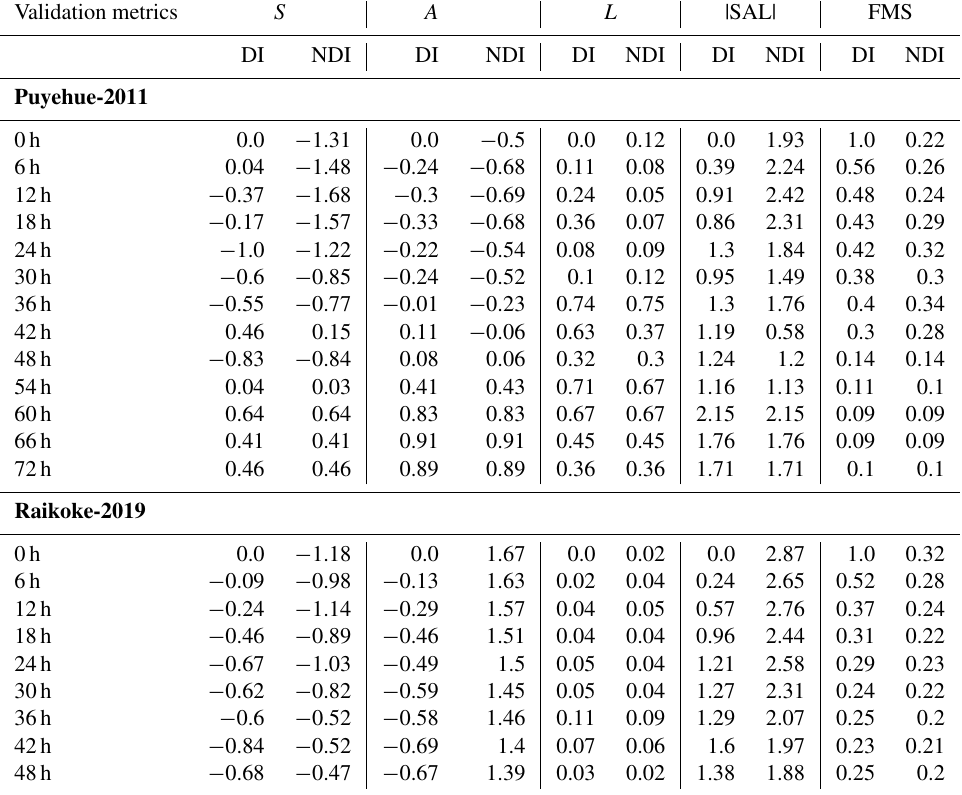
Table 4. Summary of the SAL and FMS validation scores for the Puyehue-2011 and Raikoke-2019 test suite cases. The “DI” columns indicate validation scores for runs with data insertion and “NDI” indicates scores for runs with no data insertion.